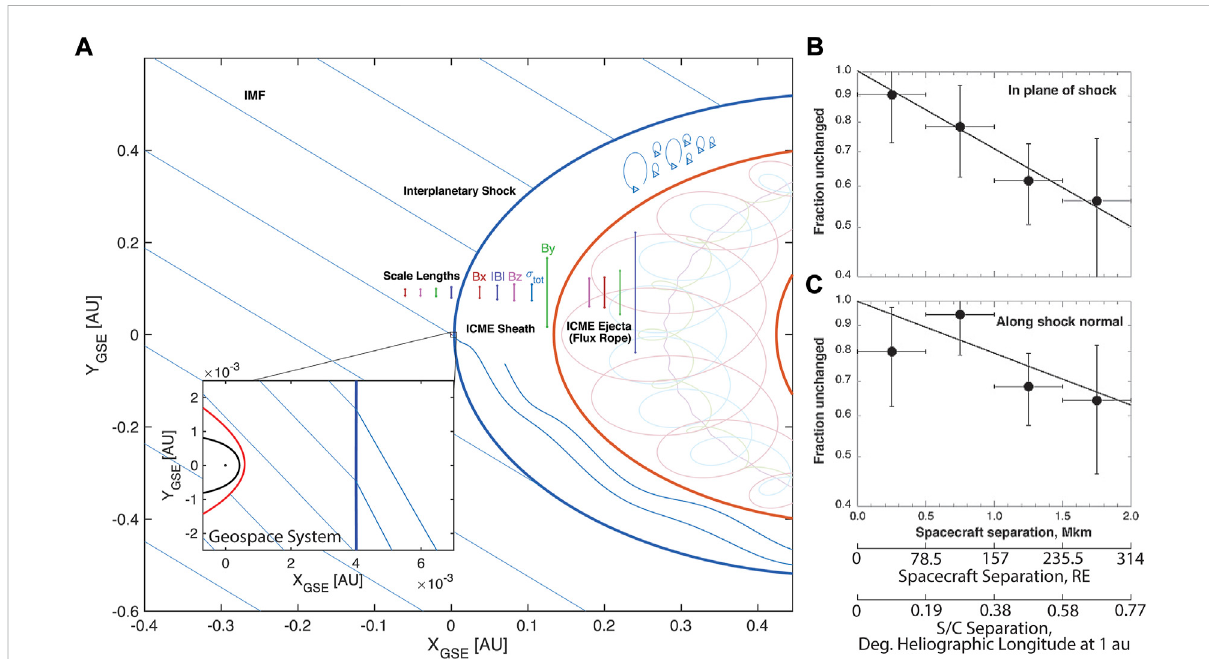
FIGURE 3 (A) Relevant scale sizes of CME structures at 1 au (from Ala-Lahti et al., 2020). The fraction of 20 – 126 keV ion time intensity pro fi les that remain unchanged between two observing points as a function of spacecraft separation both (B) in the plane of the shock and (C) along the shock normal shows distinct variability that may be related to the variable scale sizes of CME sub-structuring (from Neugebauer et al., 2006). The mesoscale structuring and subsequent effects on particle acceleration remain outstanding open questions in